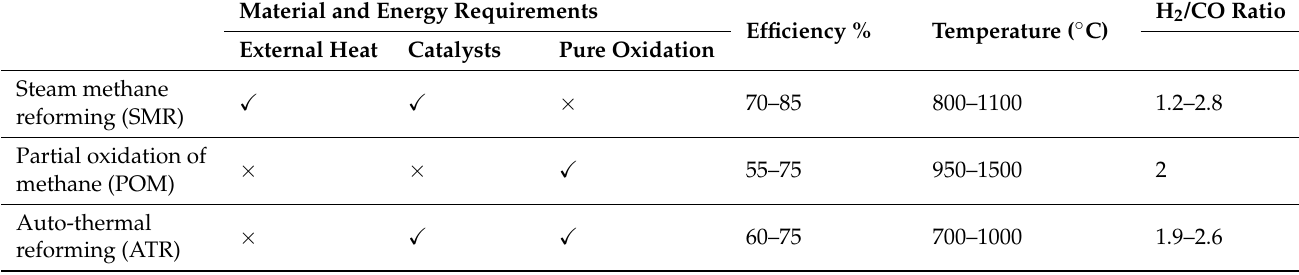
Table 3. Comparison of three methods of hydrogen production from natural gas. Reprinted with permission